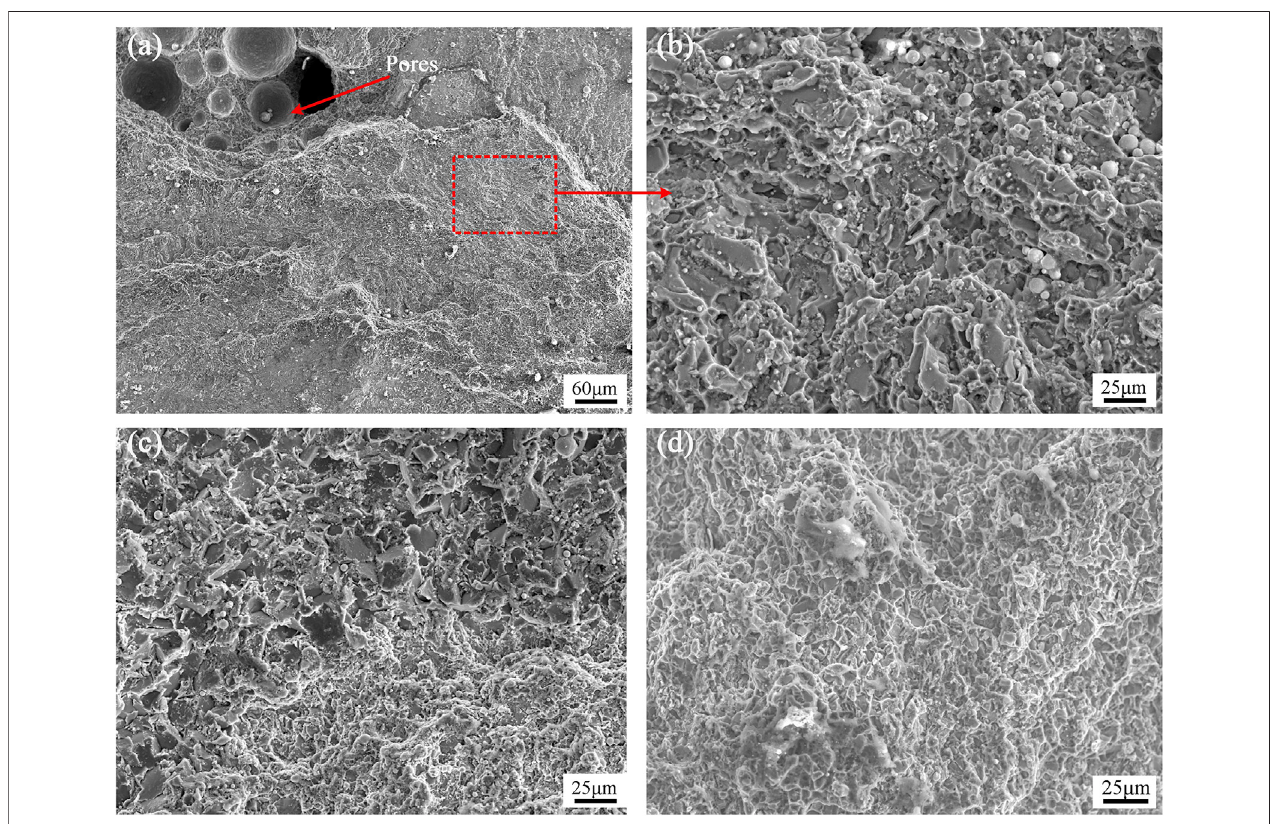
FIGURE 14 | Micrographs offractured tensile specimens under three different process conditions: (A) direct laser welding (B) enlarged view of direct laser welded joint (C) laser welded joints wiht Ti interlayer (D) ultrasonic-assisted laser welding with Ti interlayer.